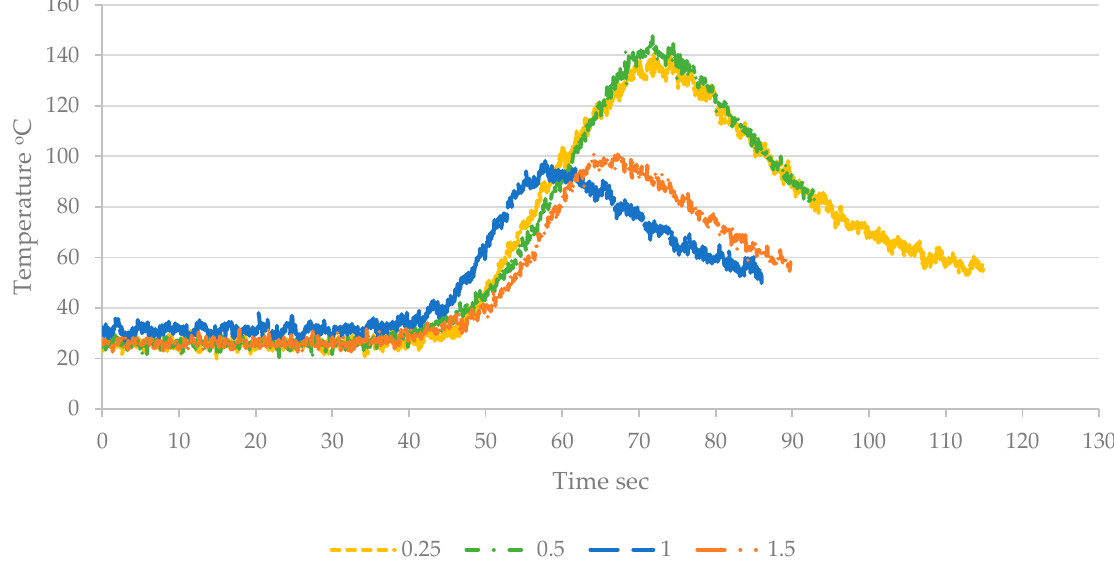
DWP = 0.25 to 1.5.